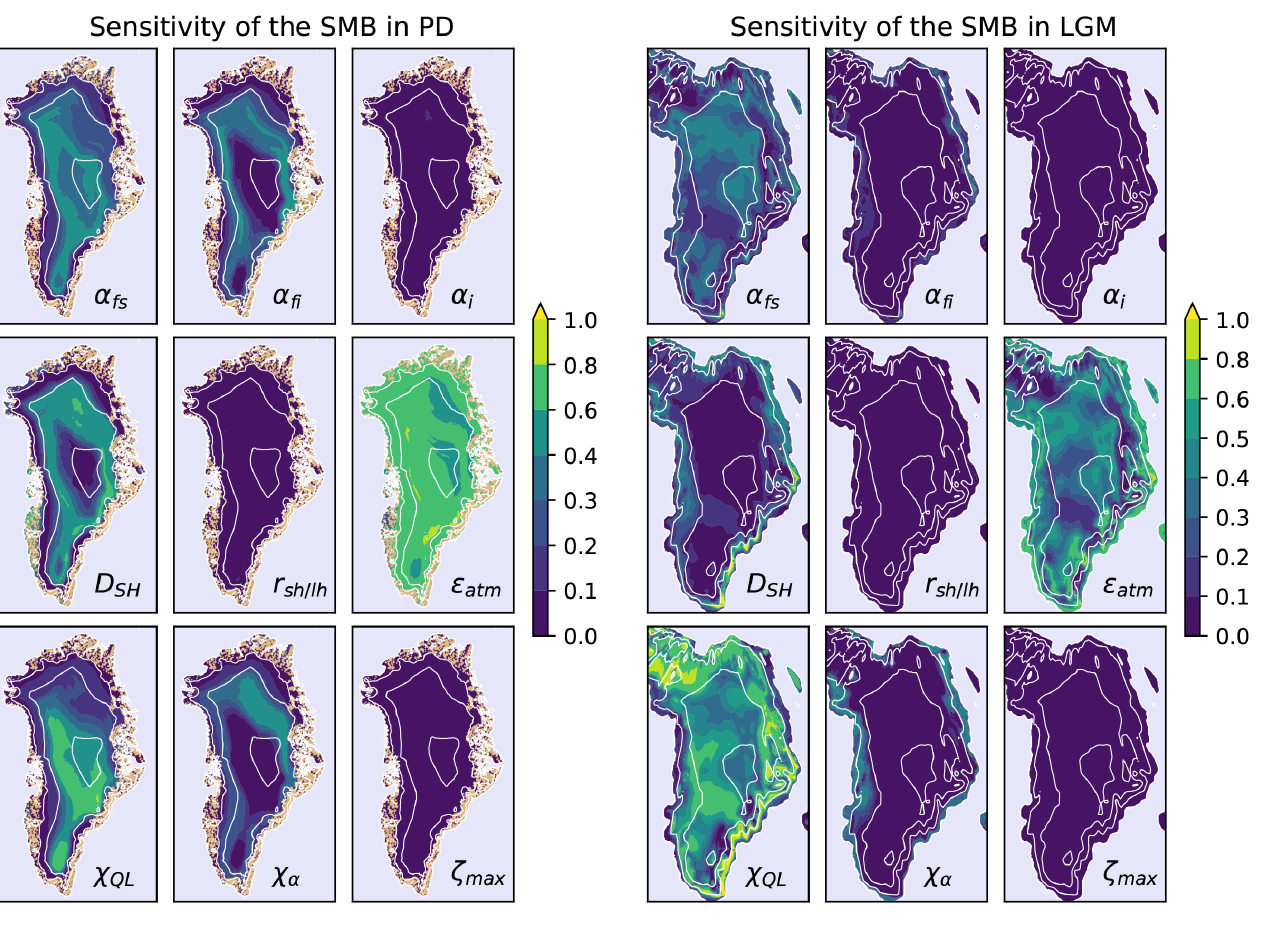
Figure 3. Global sensitivity in the PD. The total sensitivity index of the SMB of every parameter for the PD is displayed for every ice-covered grid cell. The ice-free land is in brown; the ocean is in light blue; 1000m contours are in white. The sensitivity is largest for the atmospheric emissivity (cid:15) atm , followed by the fresh snow and firn albedo α fs / fi , the turbulent heat exchange coefficient D SH , and the latent heat flux switch χ QL . The SMB is not sensitive to the ice albedo α i , the ratio of the turbulent exchange coefficients r lh / sh , and the liquid water content ζ i . The maps do not include uncertainty, but the uncertainties in the sensitivities are of the same order of magnitude as shown in Fig. 2.